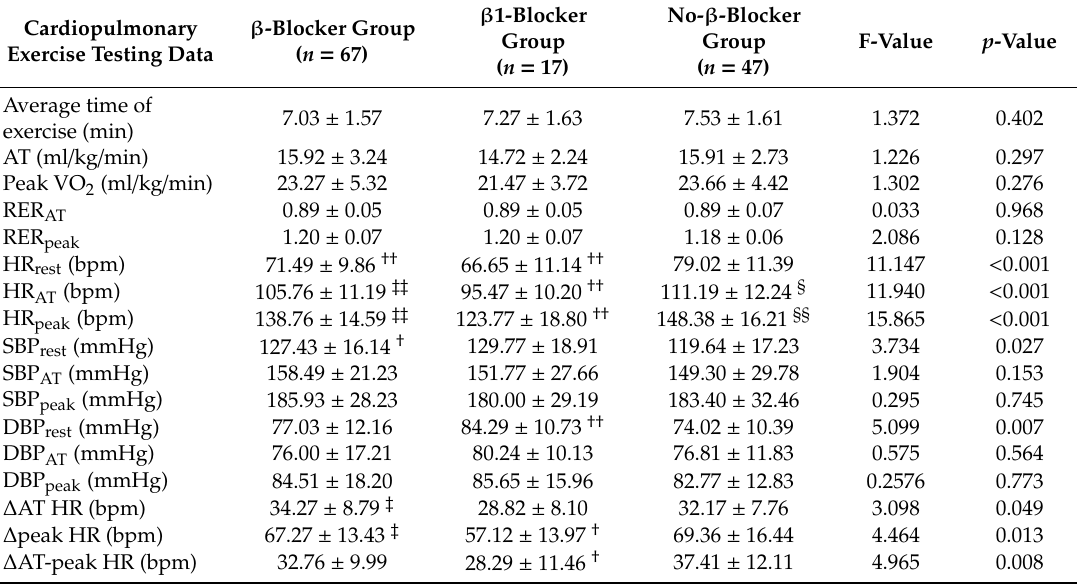
Table 2. Cardiopulmonary exercise testing data with gas